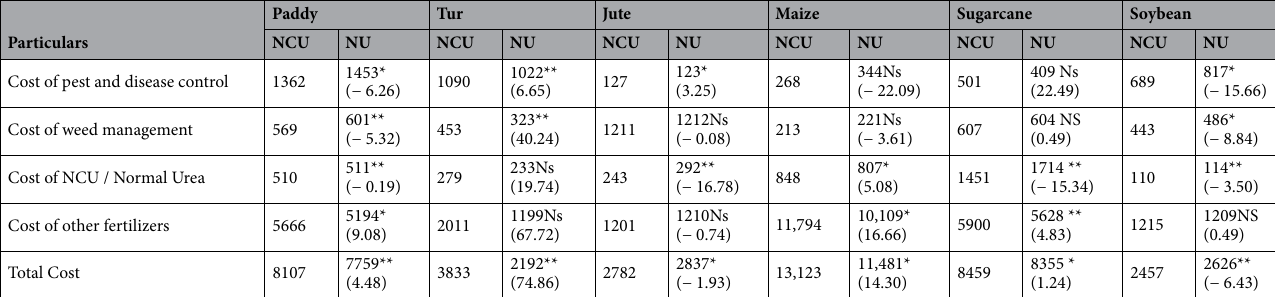
Table 7. Impact of NCU use on the component-wise cost of reference crops. (Value in Rs/acre). Source: Authors’ estimates using field survey data. ** & * denotes significance level at 1 and 5%, respectively; Figures in parentheses indicate percentage change.